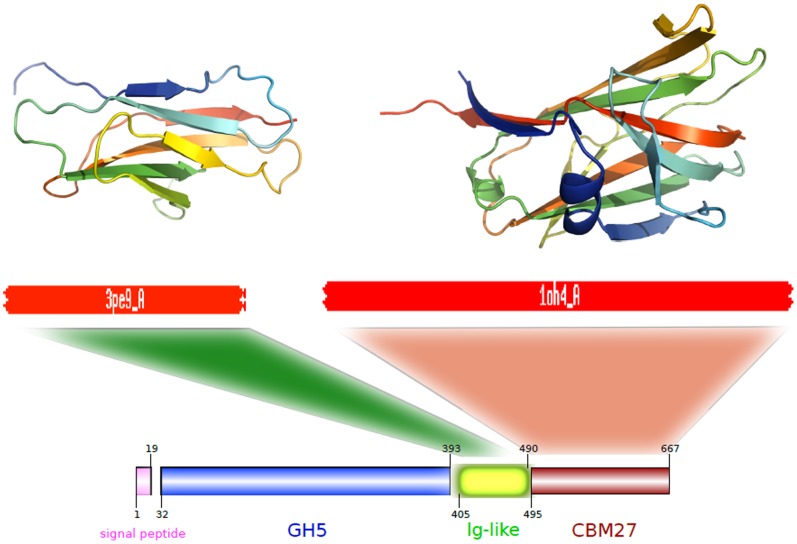
Threading methods and molecular modeling.The templates obtained by threading methods are carbohydrases from thermophilic bacteria. The central domain (TpManIg-like) was directly modeled from to X1 domain from CbhA [23]. TpManCBM27 was directly modeled from to CBM27 from TmMan [22].